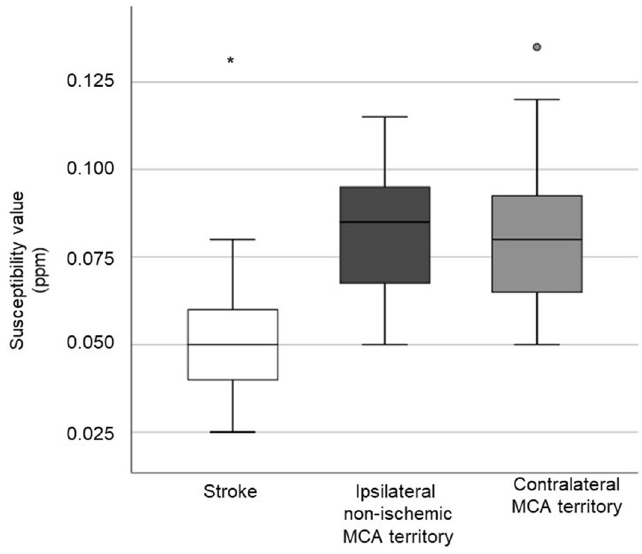
Figure 4. Comparison of the susceptibility values of the cortical veins within the stroke area, the ipsilateral non-ischemic MCA territory and the contralateral MCA territory. Areas that significantly (p < 0.05) differ from other areas regarding their susceptibility value are indicated (*)°indicates